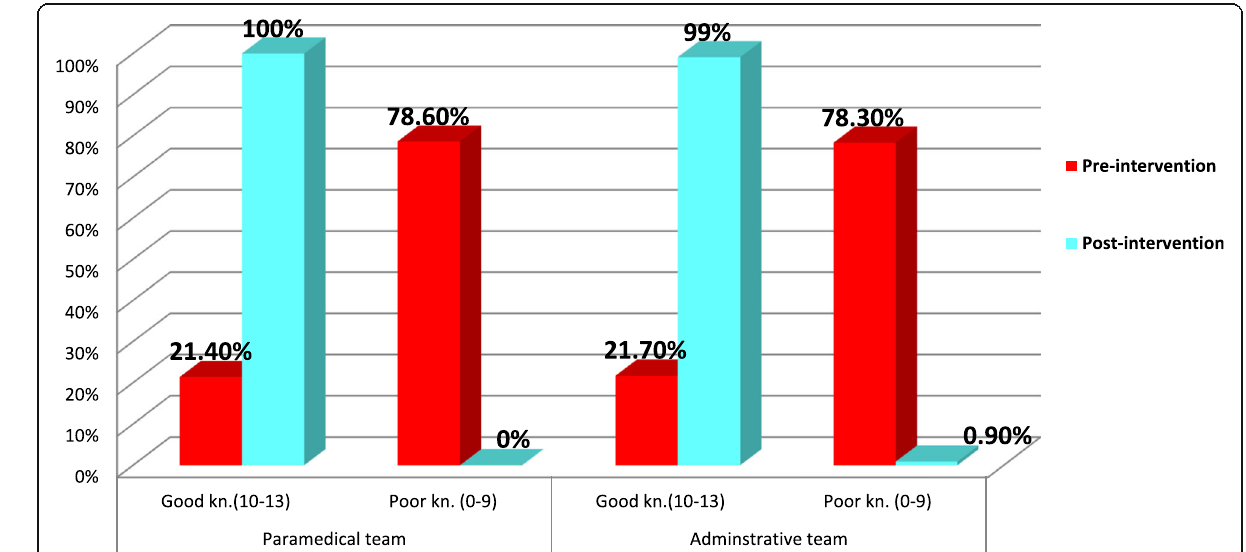
Fig. 1 Effect of education intervention on total knowledge scores of the paramedical and administrative team participants, pre- and